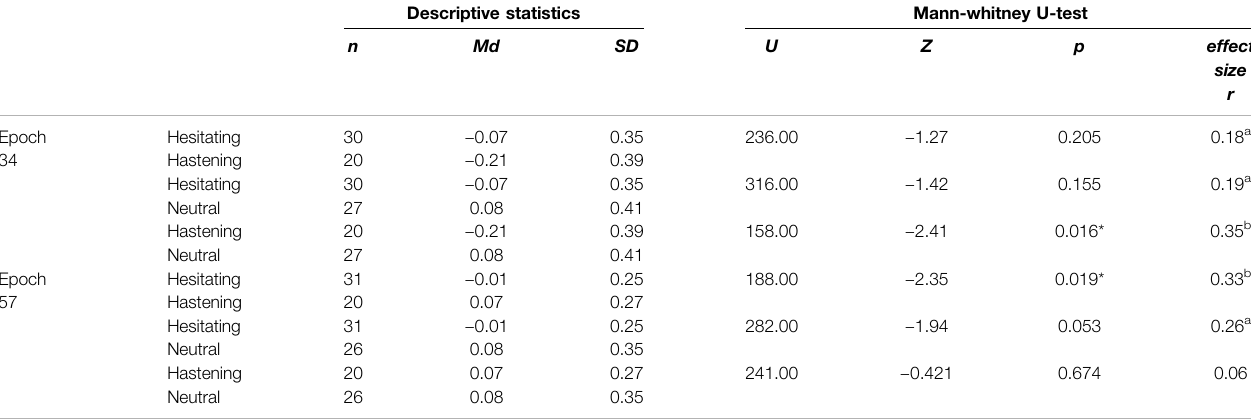
TABLE 4 | Test statistics for Mann-Whitney U-test regarding the FAA scores during epoch 34 and epoch 57.